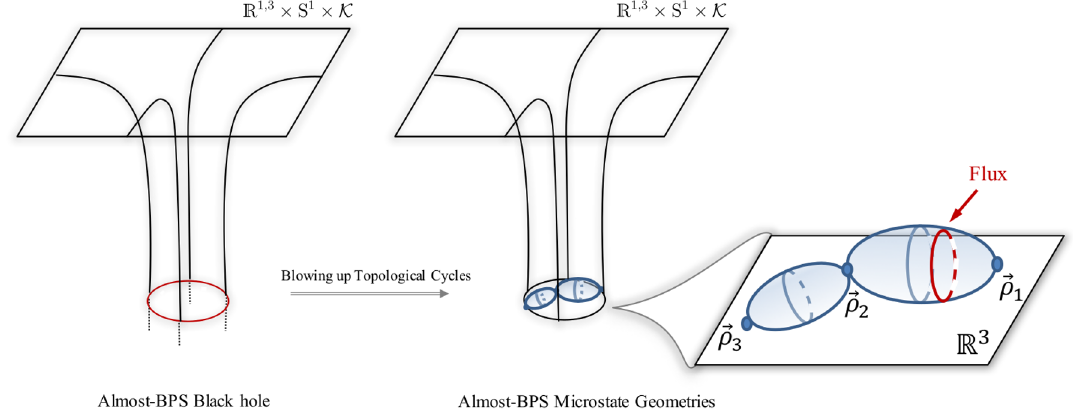
Figure 1 : Schematic description of the time-slices of an almost-BPS black hole and their corresponding multicenter smooth solutions. The horizon is resolved by blowing up topo- logical cycles wrapped by fluxes in higher dimensions, where K denotes these extra com- pact